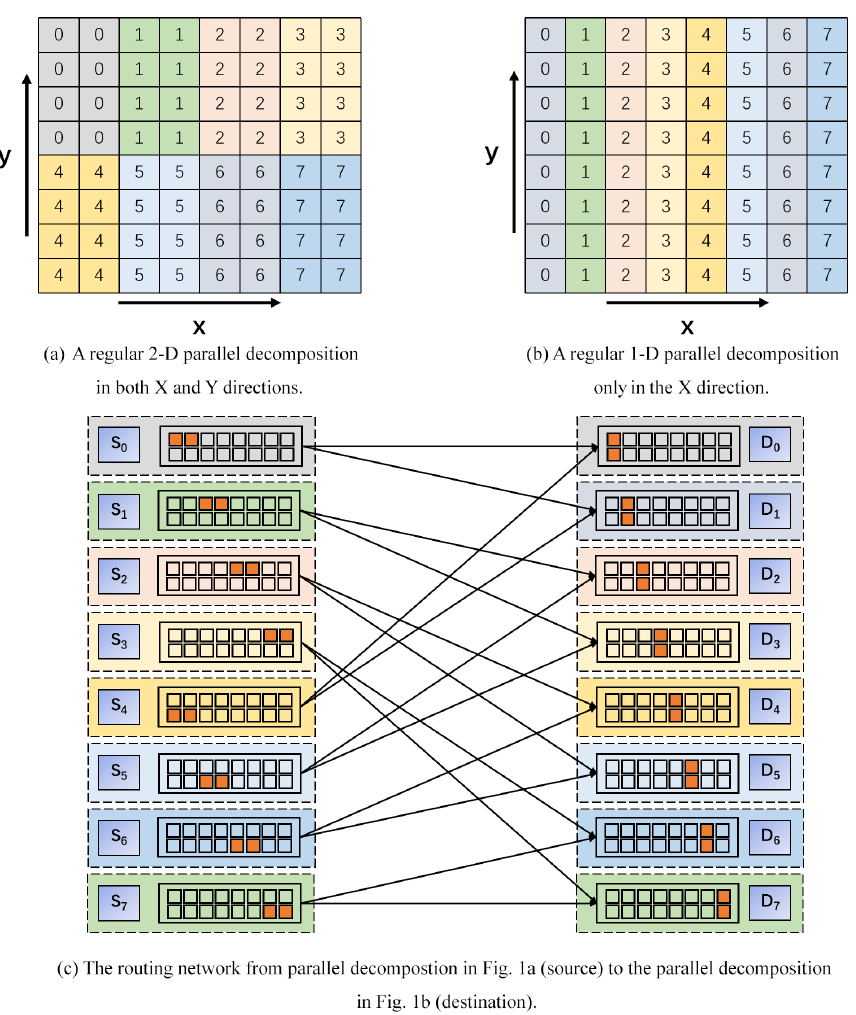
Figure 1. Two sample parallel decompositions of an 8 × 8 grid under eight processes (a, b) and the routing network between them (c) . Each color corresponds to a process. The left (for processes S 0 –S 7 ) and the right (for processes D 0 –D 7 ) in (c) correspond to the parallel decompositions in (a, b) respectively. A smallest square in (c) represents four continuous grid points in a column in (a) or (b) , where a square that corresponds to local grid points of a process is in